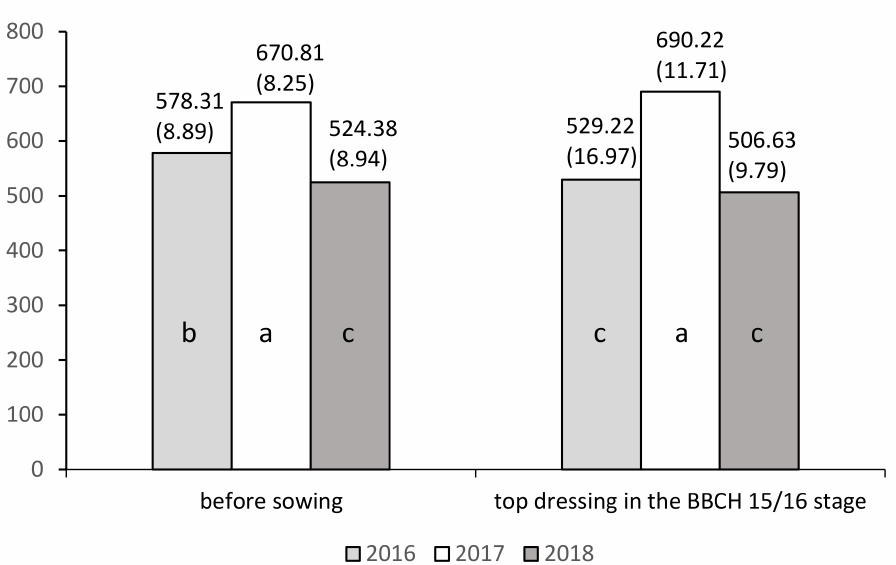
Figure 4. Mean values of index SPAD for the combinations of three years (Y) and two dates of nitrogen application (C factor): BBCH 17/18. a, b, c: homogeneous groups ( p ≤ 0.05). Standard errors are in